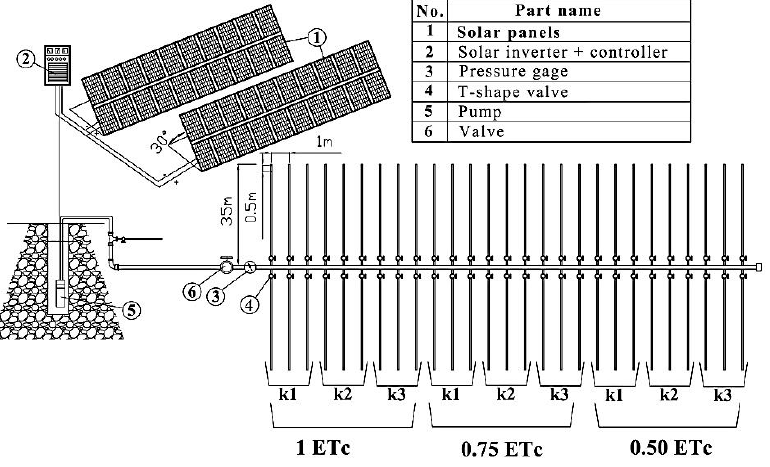
Figure 1. A schematic layout of the solar-powered pumping system connected with the drip irrigation